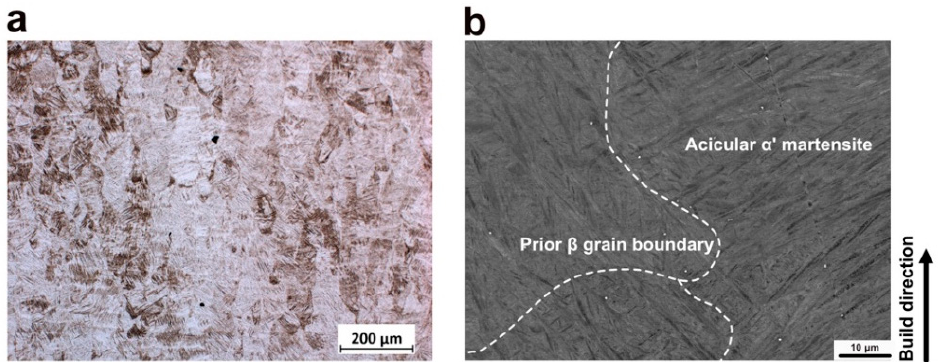
Figure 3. Microstructure of as-fabricated Ti-64 samples, ( a ) optical microscopy image; ( b ) back-scattered electron image.